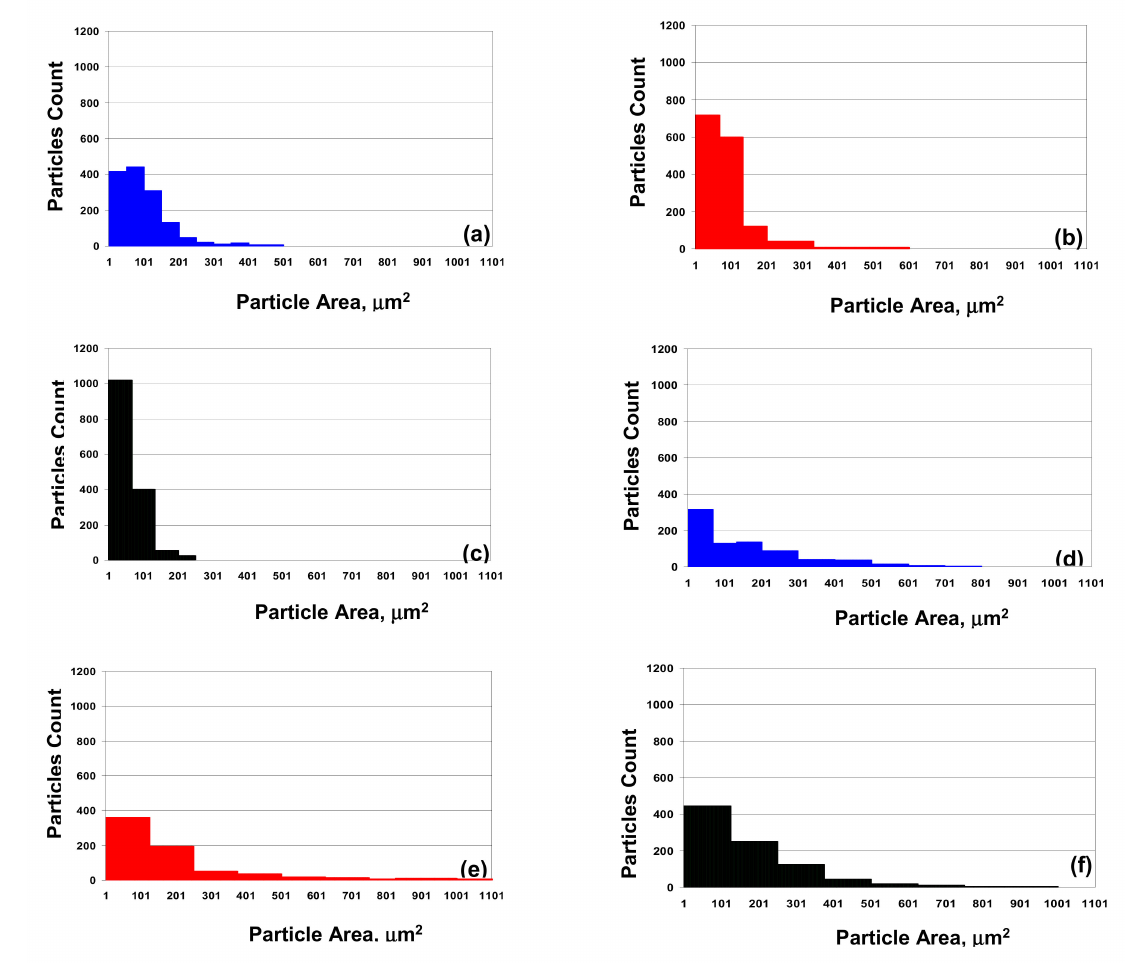
Figure 5. Size (area) distribution of graphite particles at 3.5 mm ( a – c ) and 10 mm ( d – f ) wall thickness in inoculated ductile cast irons ( a , d —Ca; b,e —Ca,Ba; c , f —Ca,RE). The cooling rate (wall thickness) has a visible e ff ect on graphite phase parameters. Lower graphite particles area (Figure 4a), at lower standard deviation in graphite particles size (Figure 4b), expressed by standard deviation of the graphite particles area shown in Figure 4a, and higher graphite particles count (Figure 4c) characterizes the thin wall solidification (3.5 mm width of wedge casting),